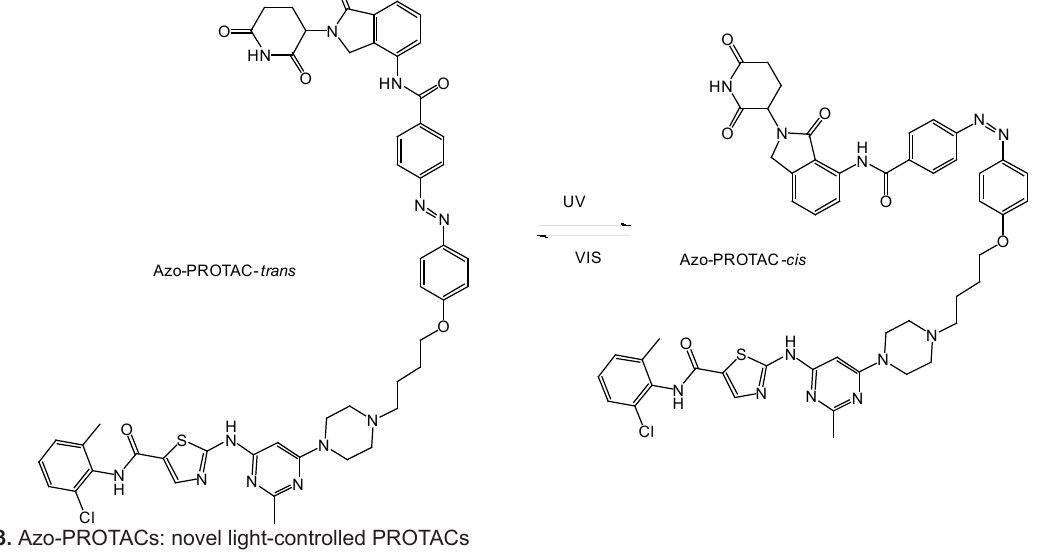
linear PROTAC. Despite a 12-fold loss in binding affinity for BRD4, macro-PROTAC exhibited cellular activity comparable to MZ1, one of the most potent PROTACs reported to date.